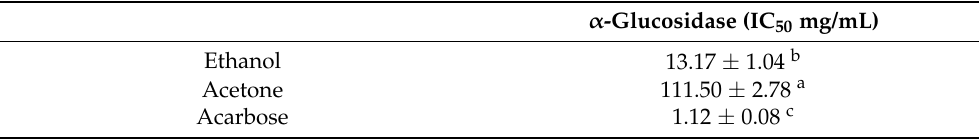
Table 7. Inhibitory activity of α -glucosidase of two A. indicum extracts compared to authentic standard